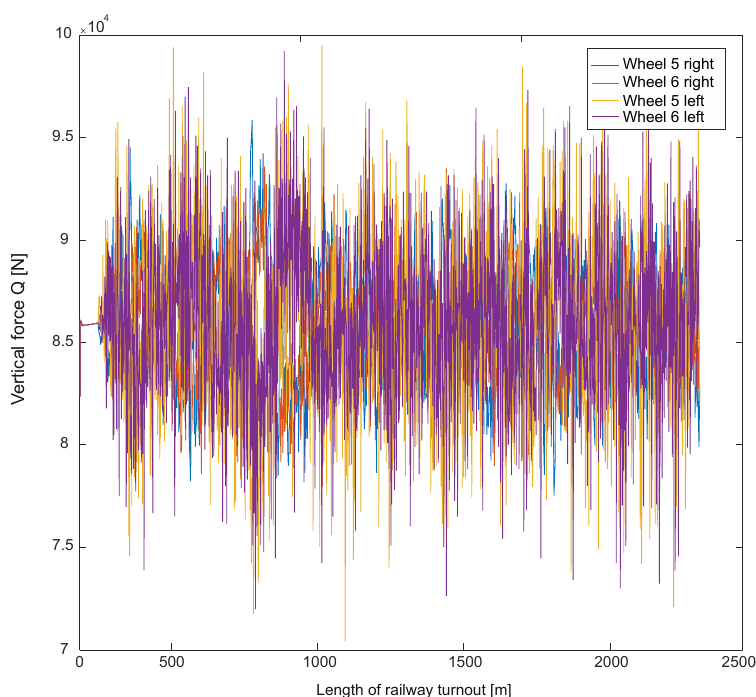
Figure 22 . Vertical force at 250 km/h on a straight track without a turnout .